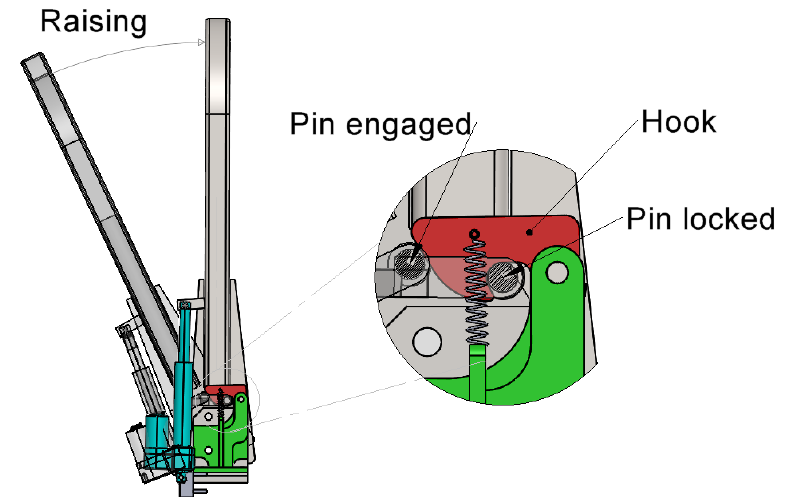
Figure 8. Scheme of the engagement and locking configuration. For the external profile of the hook, the most important geometrical feature is the inclination: thus, by simulating different values of the inclination angle of the external profile, the one requiring less dynamic variation force on the actuator during the hitting and sliding of the pin with the hook was chosen. This characteristic is well highlighted in Figure 9, where a post-processing multibody simulation diagram of the actuator force with respect to the raising angle is shown. It must be noted that the raising angle α ’ is obtained by Equation (3) to take into account the fact that the rest configuration of the FROPS does not start at α = 0 (see Figure 4):